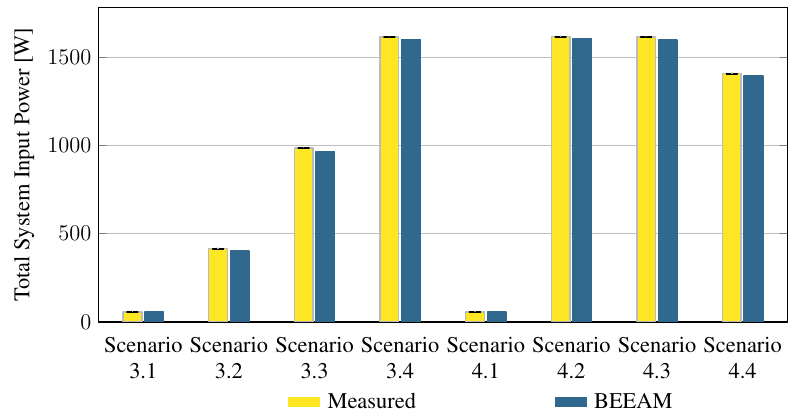
Figure A9. Predicted versus measured total system input power, Scenarios 3 and 4.